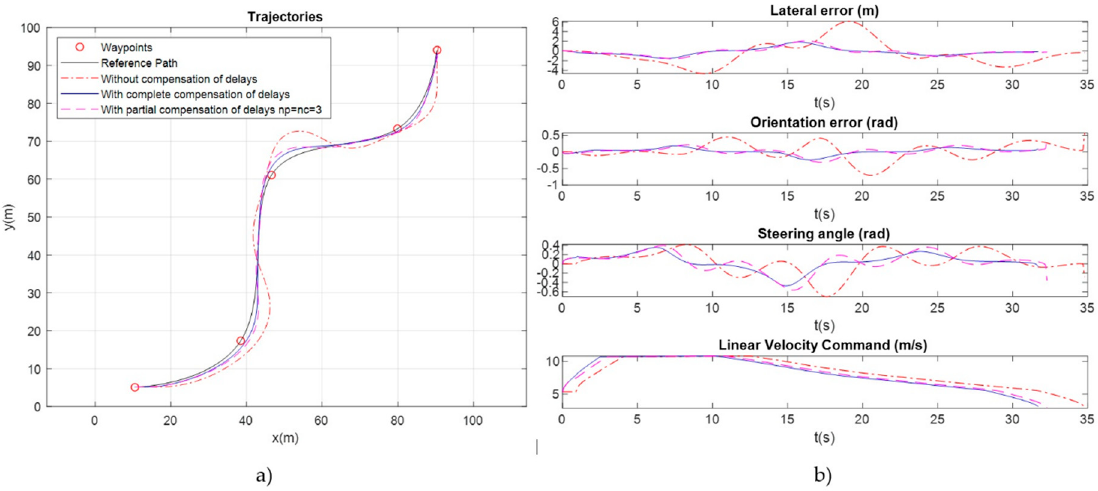
Figure 8. Effect of delays and their compensation: ( a ) resulting trajectories and ( b ) tracking errors and control signals. Delays of n p = n c = 5 have been simulated in the sensors and actuators of the vehicle, and results are shown in the following cases: without compensation of delays (red dot-dashed line), with a partial compensation of the delays using n p = n c = 3 in the compensator (magenta dashed line) and with a complete compensation of the delays (continuous blue line).